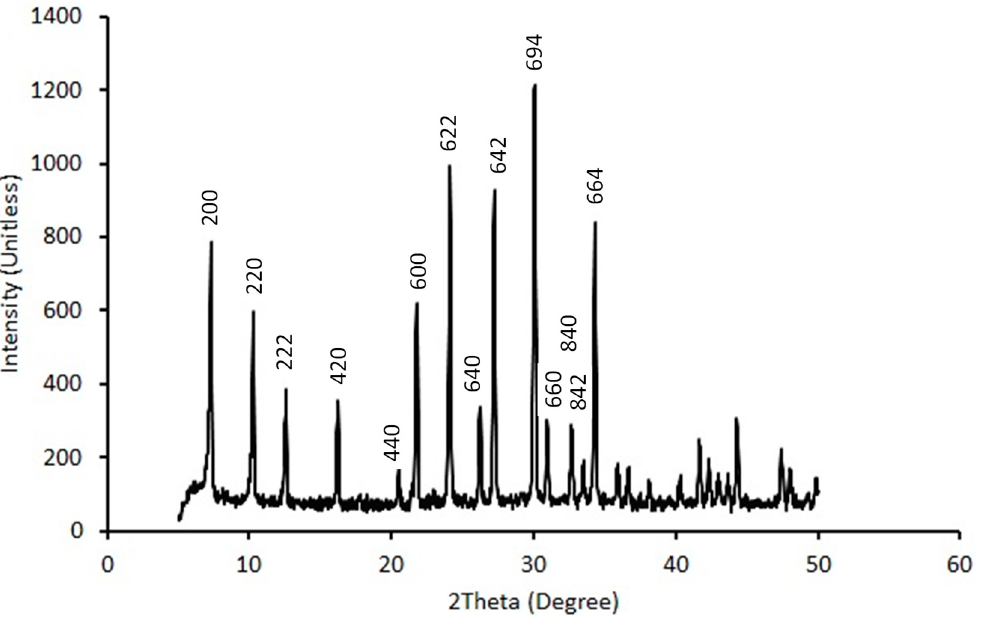
Figure 1. XRD pattern of the prepared 4A zeolite.